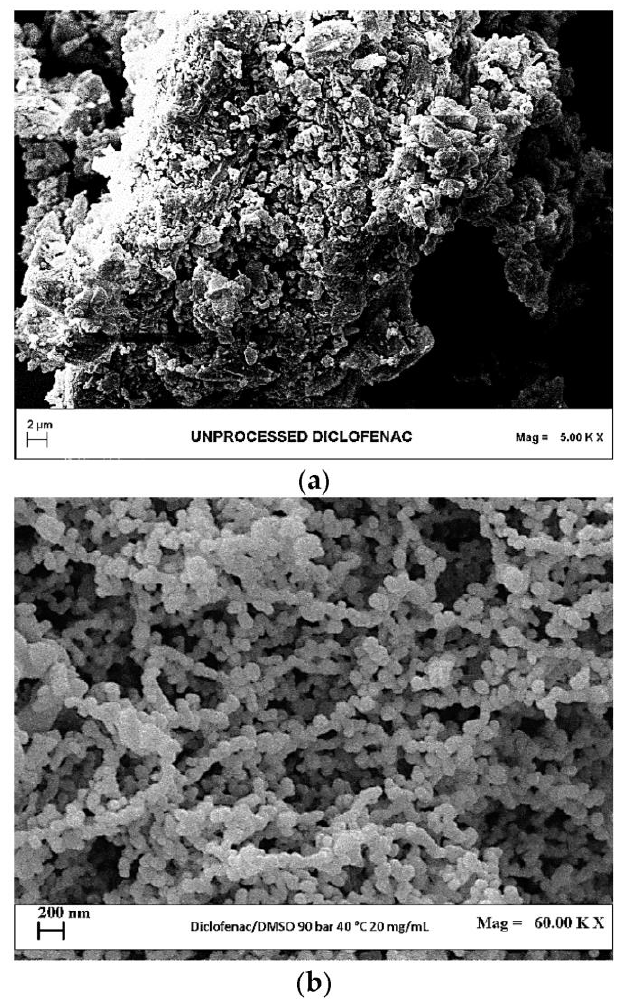
Figure 5. SEM images of ( a ) unprocessed diclofenac sodium and ( b ) nanoparticles of diclofenac sodium produced by the SAS process.